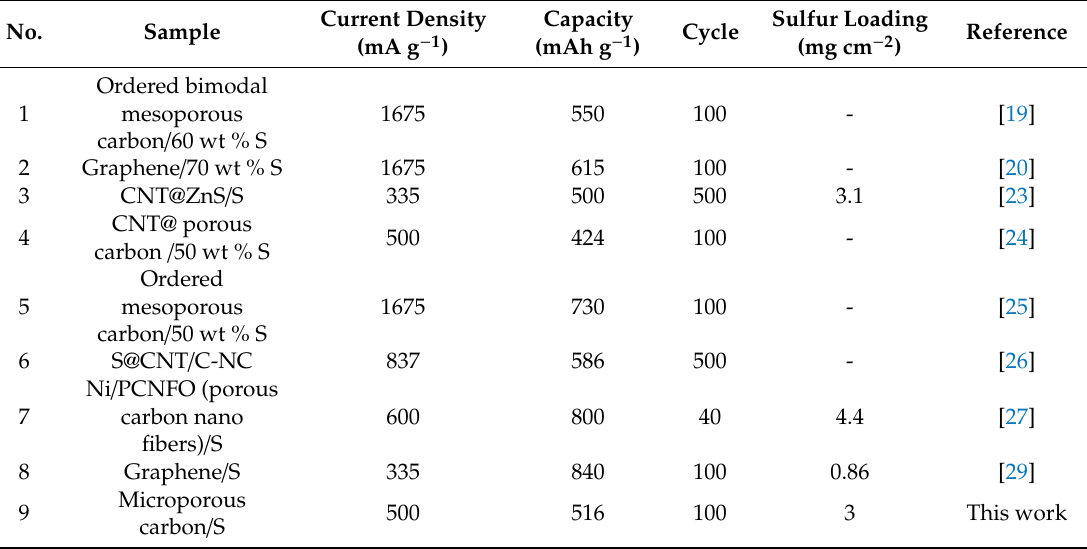
Table 6. The comparison of electrochemical